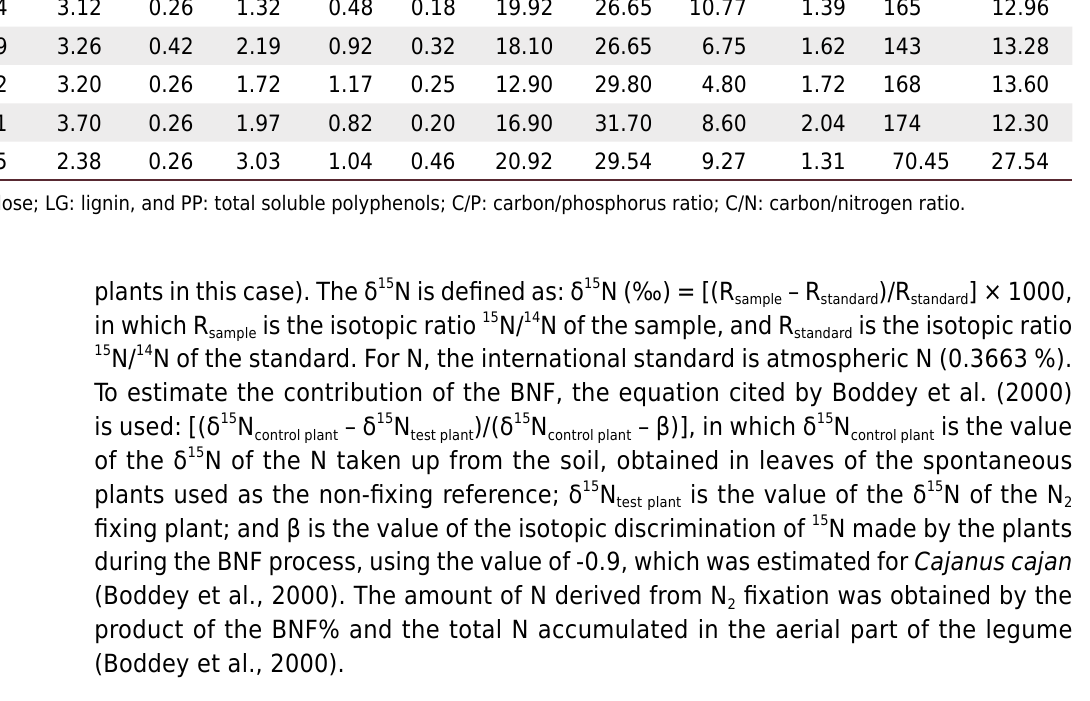
cajan (3.01 Mg ha -1 ).